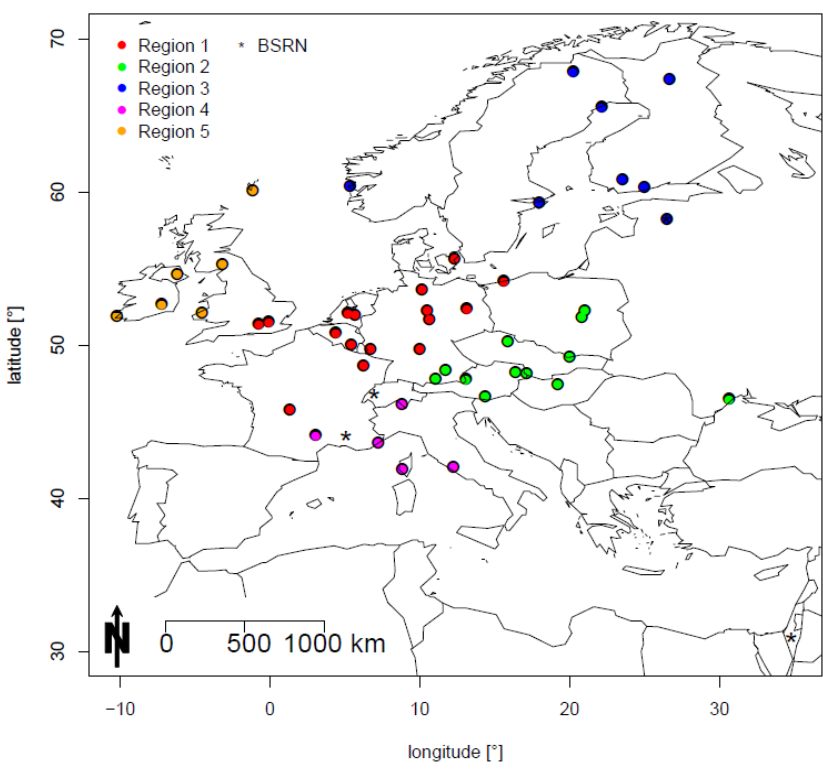
Figure 1. Locations of 47 Global Energy Balance Archives (GEBA) and four Baseline Surface Radiation Network (BSRN) stations over Europe. The GEBA stations are colored according to the region they have been assigned to (see explanation in